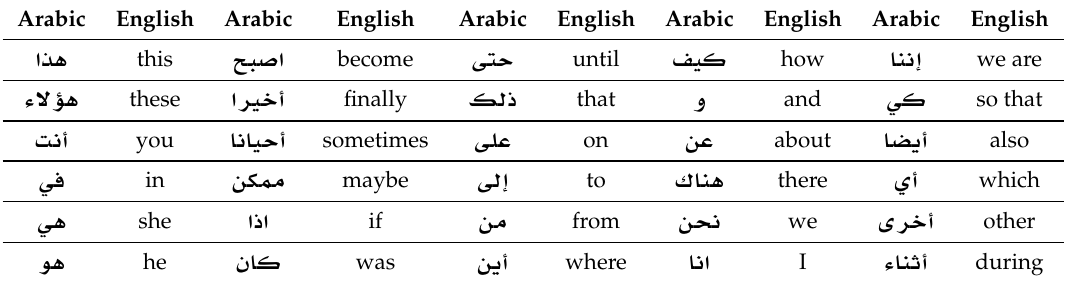
Table 1. Typical stopwords in Arabic and their corresponding English